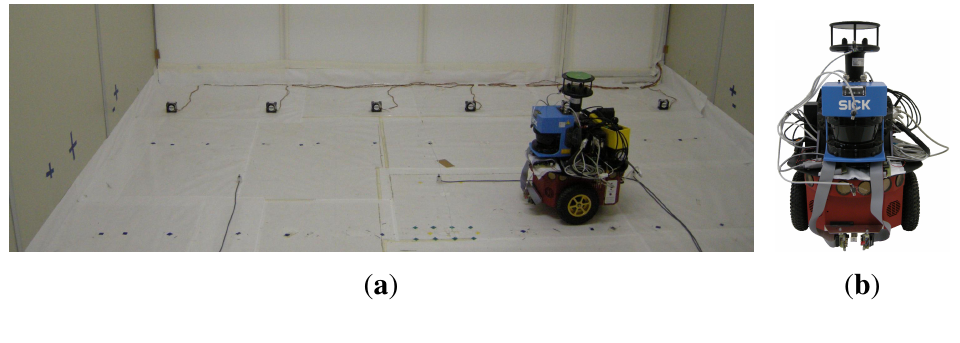
Figure 4. ( a ) Robot Arena. ( b ) Pioneer P3-DX platform.